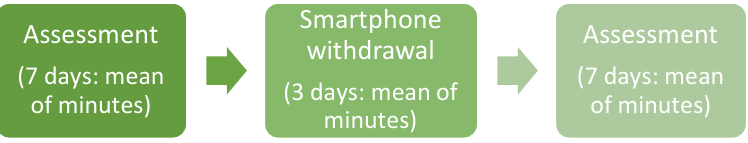
Figure 3. SocialStatsApp Research Design Schema.